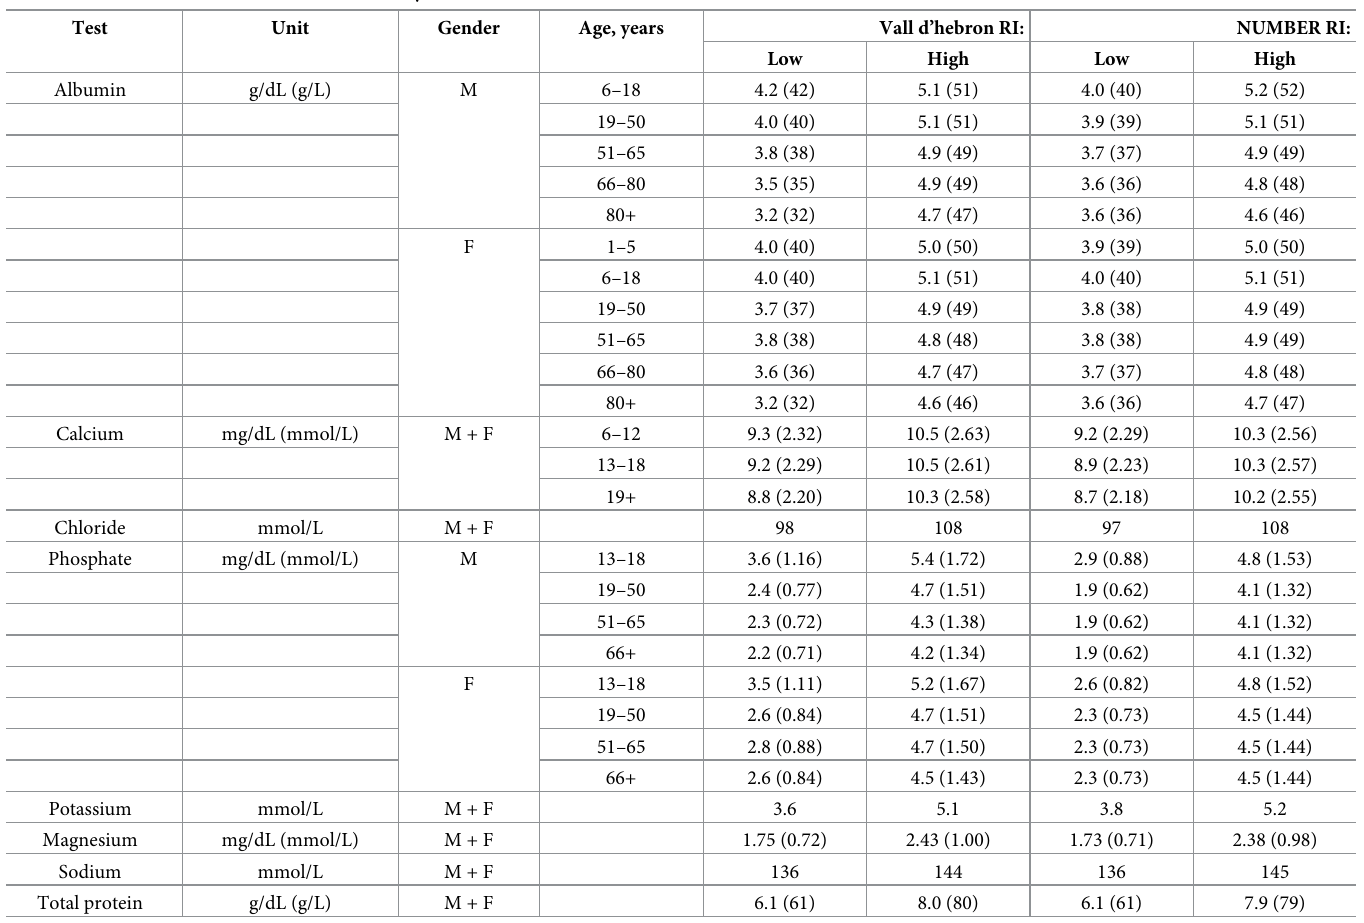
Table 2. Reference intervals results from normally distributed